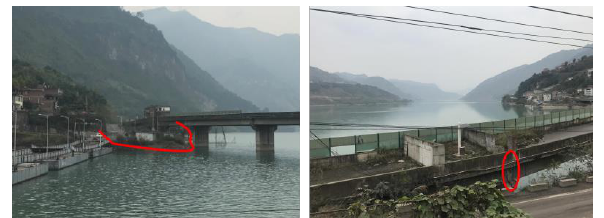
Figure 11. Deformation of bridge below landslide body(The bridge was banned from traffic on March 3, 2017 due to security risks)